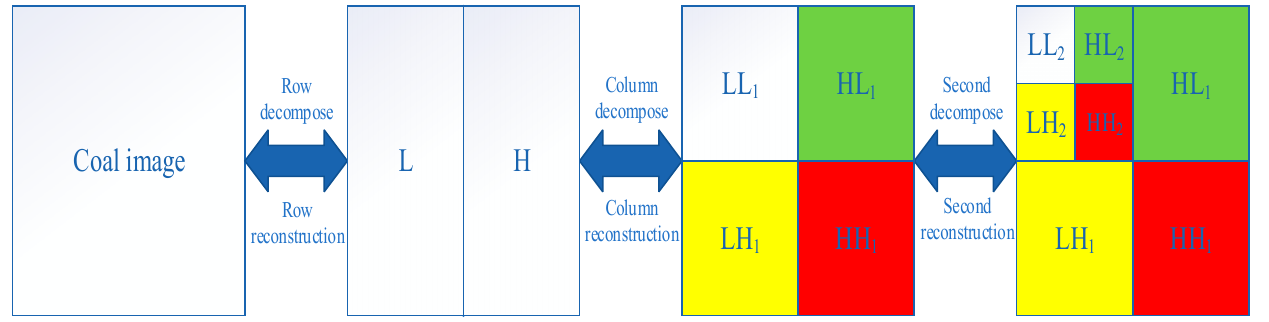
Figure 4. The wavelet-transform steps for coal image.